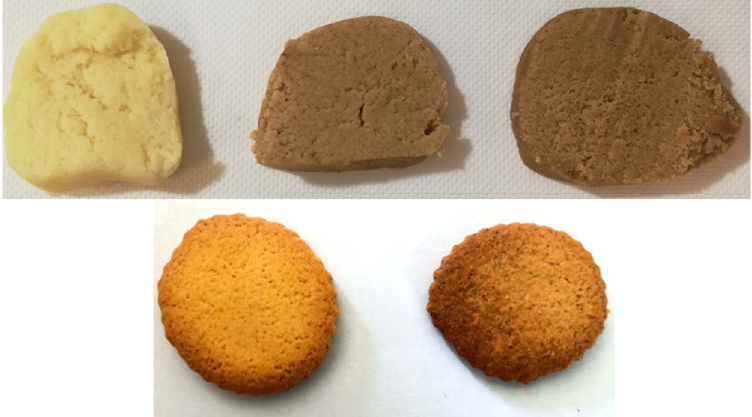
Figure 5. ( Upper panel) Appearance of the raw doughs for biscuit preparation. ( Left ) BD, ( middle ) PPP3, ( right ) PPP5 doughs before baking at 180 °C for 20 min. ( Lower panel) The BD ( left ) and PPP3 ( right ) doughs after baking.